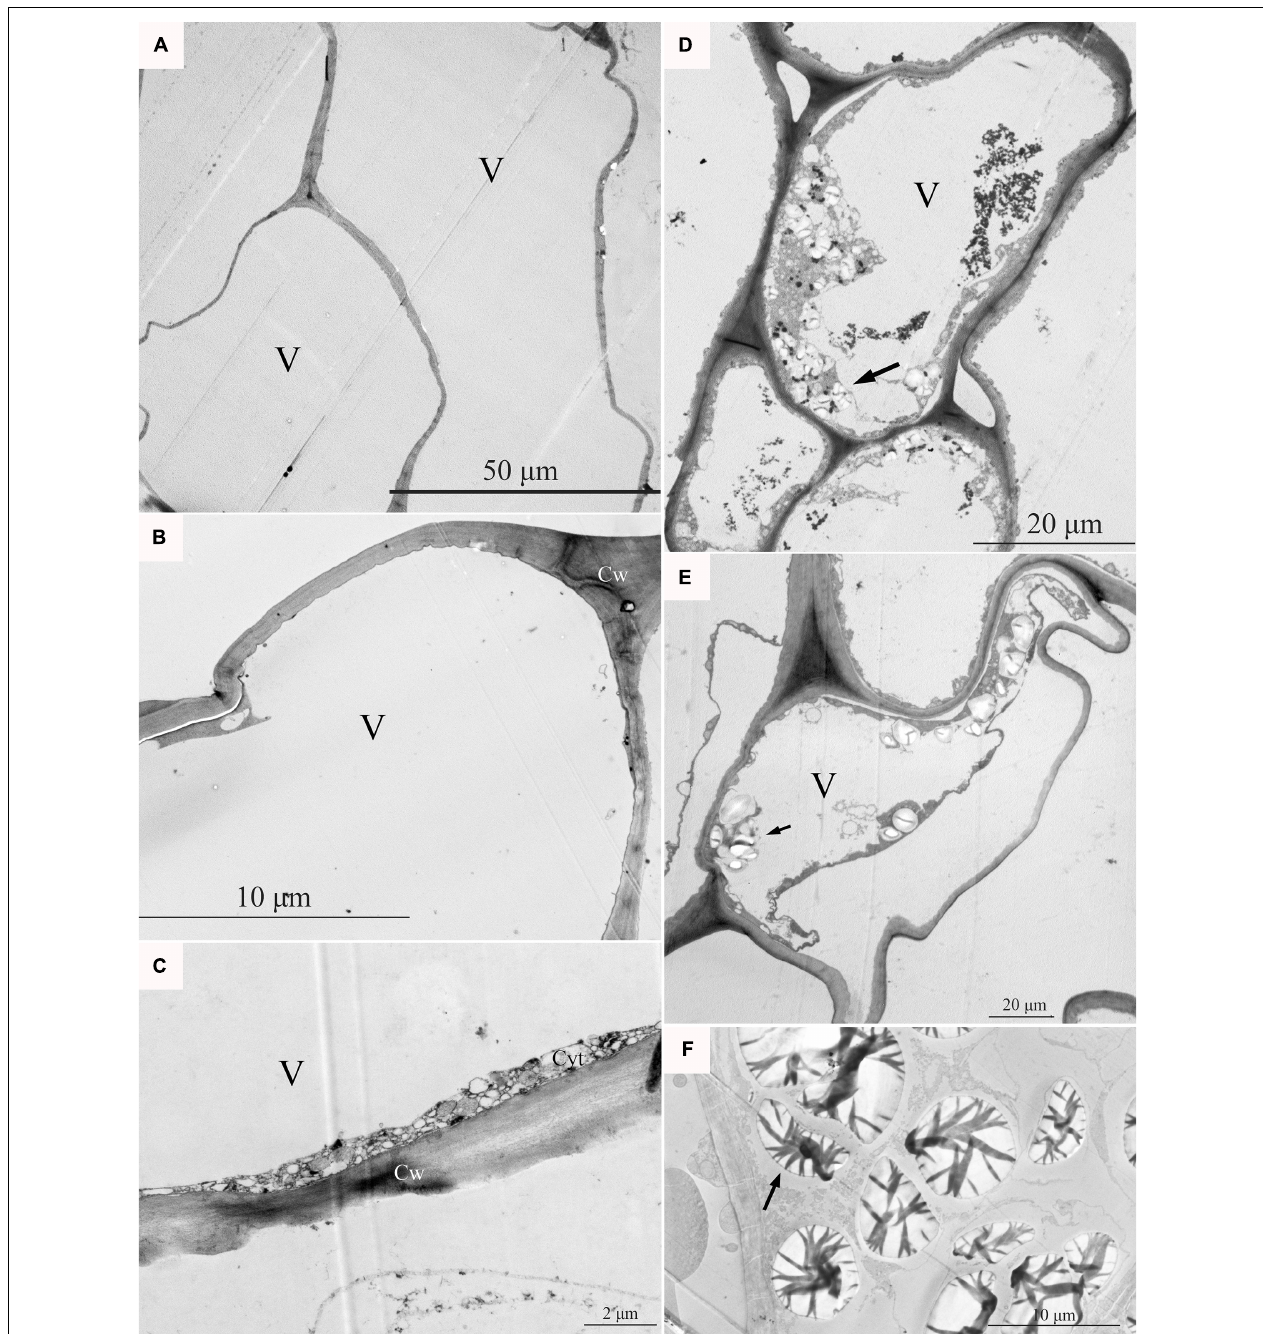
FIGURE 2 | The pulp cells were observed via transmission electron microscopy (TEM). (A–C) Pulp cells of a healthy fruit; healthy pulp cells gradually enlarge. (D) The ultramicroscopic observation of amyloplasts in bitter pit flesh cells. (E) Analysis of the flesh cells of bitter pit in apples revealed plasmolysis and abundant amyloplasts. (F) Amyloplasts further enlarged. Black arrows indicate amyloplasts. V, vacuole; Cw, cell